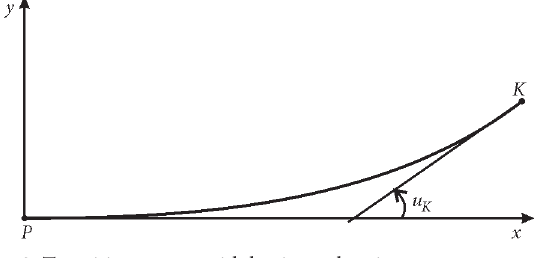
Fig. 3. Transition curves with horizontal main tangent in Cartesian coordinate system (Kobryń 2002)